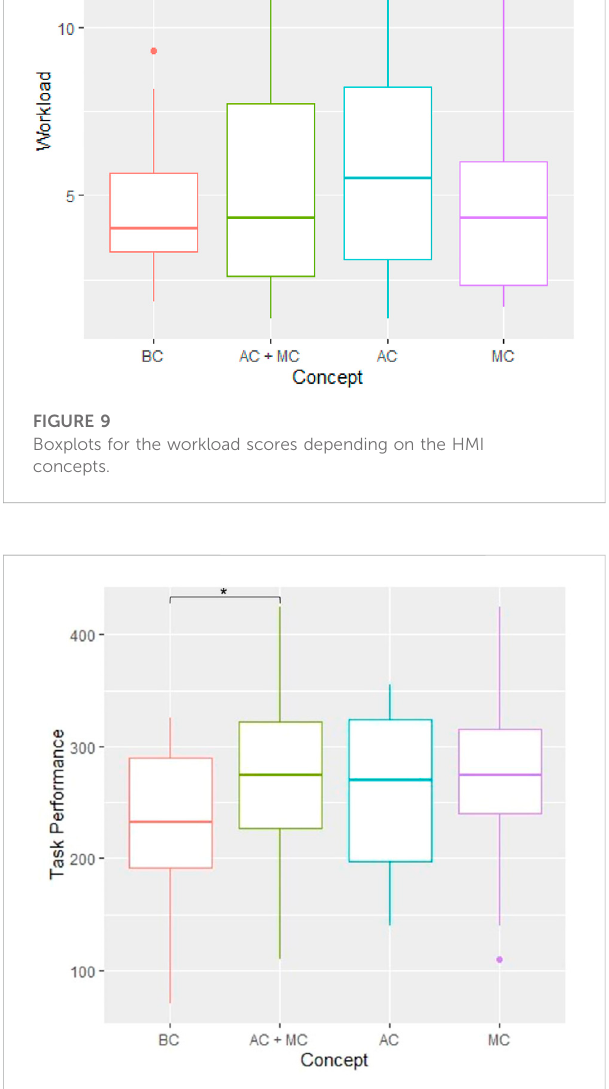
FIGURE 10 Boxplots for the task performance depending on the HMI concepts. * marks signi fi cant